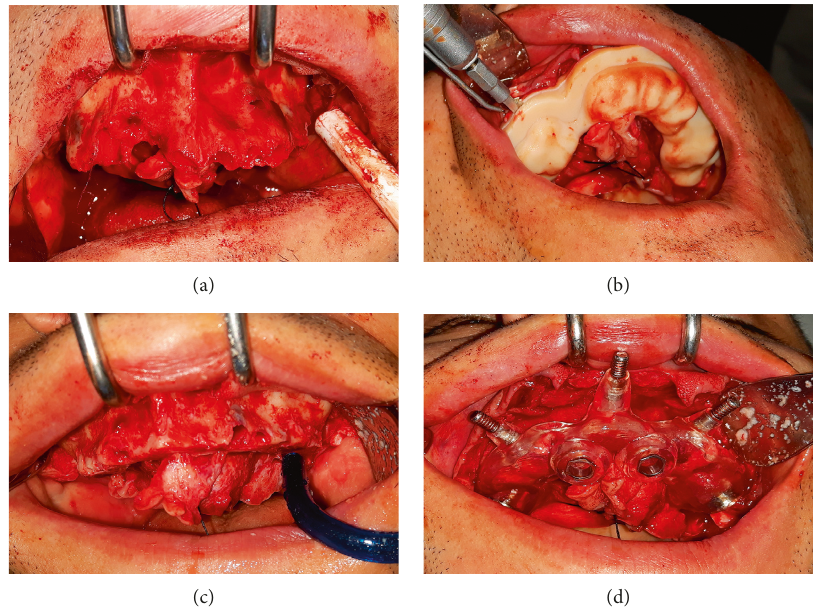
Figure 2: (a) Maxillary postextraction. (b) Ostectomy performed by saw through the guide. (c) Removal of the ostectomized bone. (d) Implant guide placed on the same holes used to fix the resection guide.